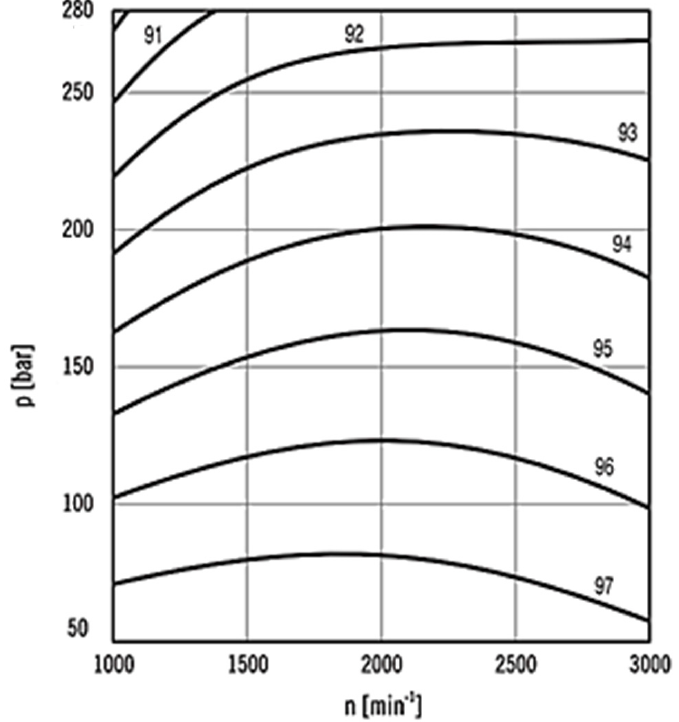
Figure 6. Volumetric efficiency of hydraulic pump/motor function of pressure and rotational speed condition.